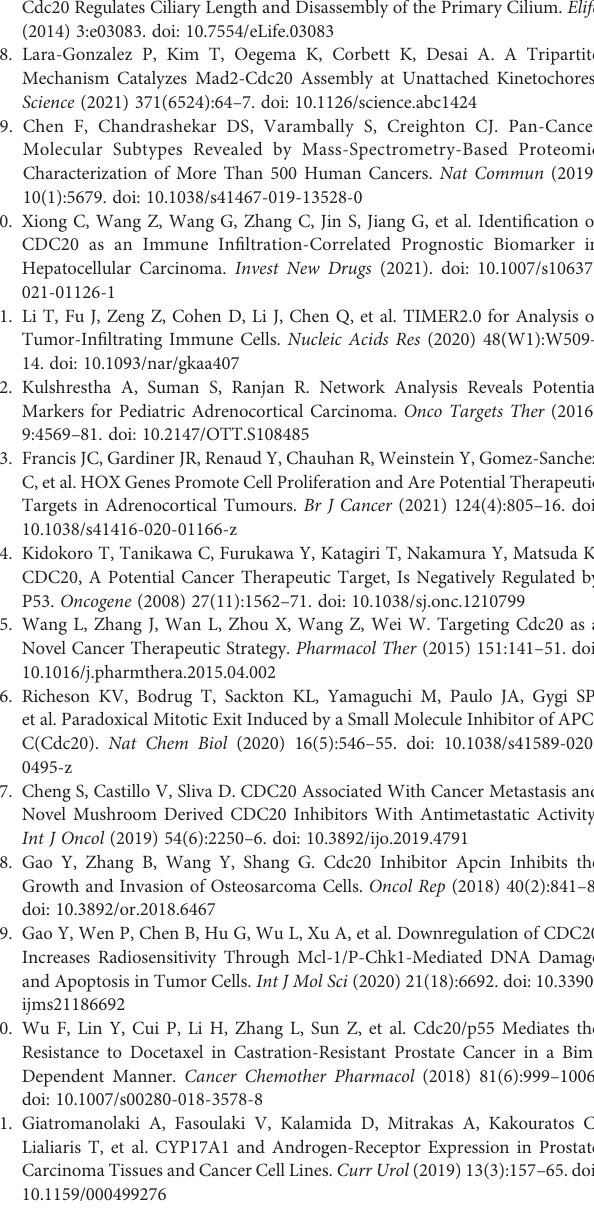
bladder cancer (A) , breast cancer (B) , colon cancer (C) , esophageal cancer (D) , gastric cancer (E) , head and neck cancer (F) , lung cancer (G) , liver cancer (H) , uterine cancer (I) and pancreatic cancer (J) , based on the Oncopression dataset. *** P < 0.001. Supplementary Table 1 | The abbreviations of cancer types in the TCGA